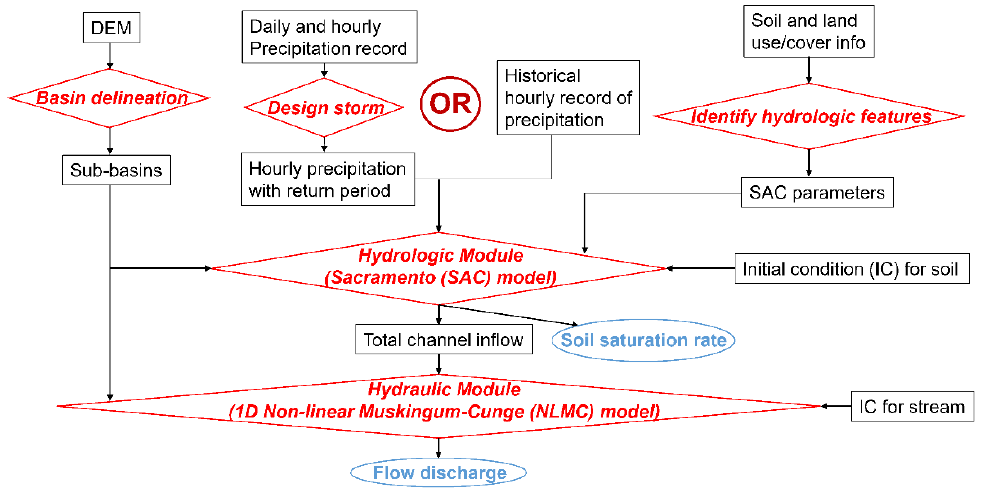
Figure 1. Flowchart of the components and links used in the numerical modeling software.